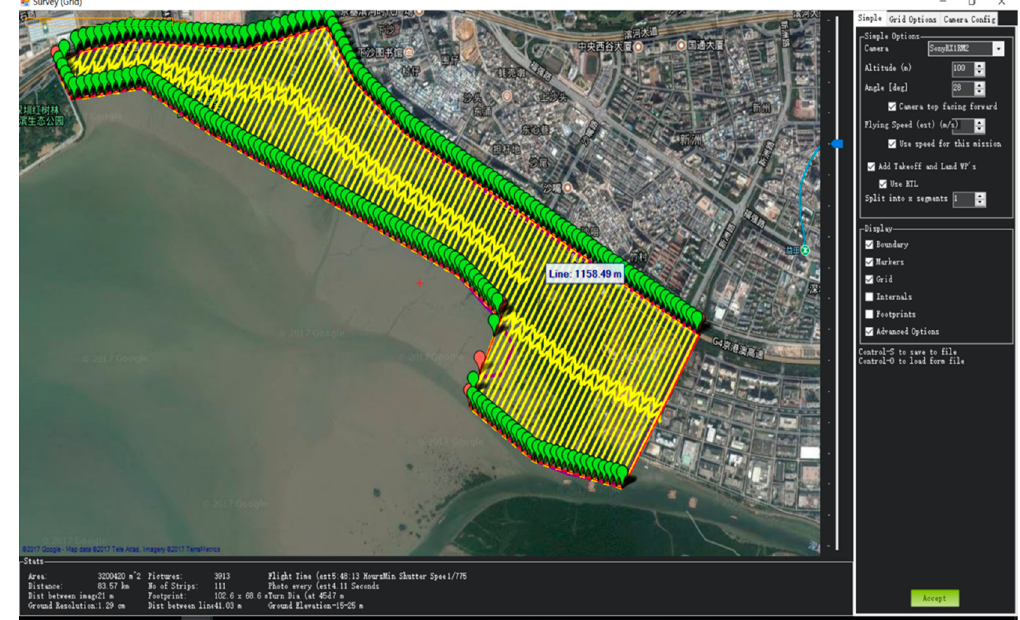
Figure A2. Flight Course Design.